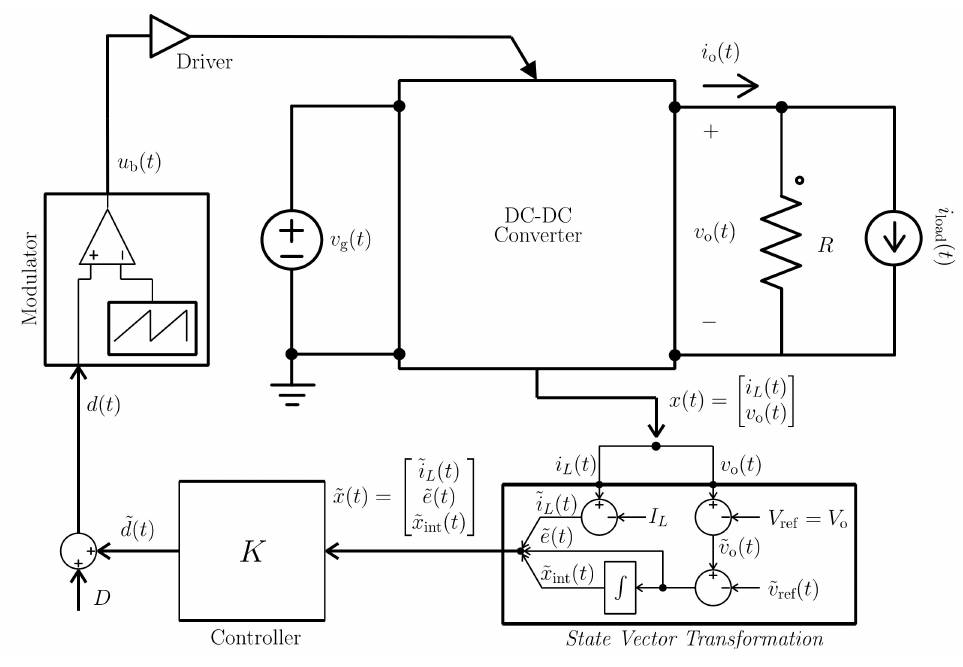
Figure 1. Schematic of a DC–DC converter with a state feedback control